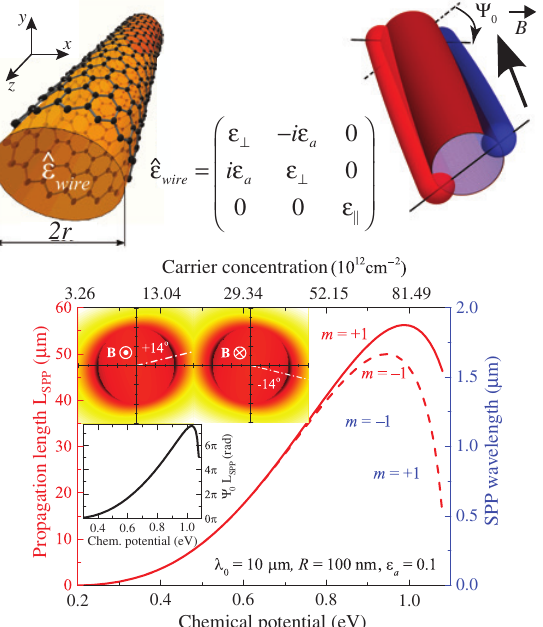
Figure 6: Magneto-plasmonics on graphene meta-surfaces. (A) Effective conductivity of the meta-surface formed by graphene stripes of the width A placed with the periodicity Λ = 50 nm in long  Λ ). Operating frequency is 10 THz. (B) SPPs wave limit (i.e. λ SPP excitation by the point source placed near the meta-surface working in hyperbolic regime. Magneto-plasmon-assisted Faraday rotation by a meta-surface placed in a perpendicular external magnetic field (C). Dashed lines correspond to uniform graphene. Adapted from [36] (A, B) and [93] to graphene. In cylindrical geometry, only the radial mag-